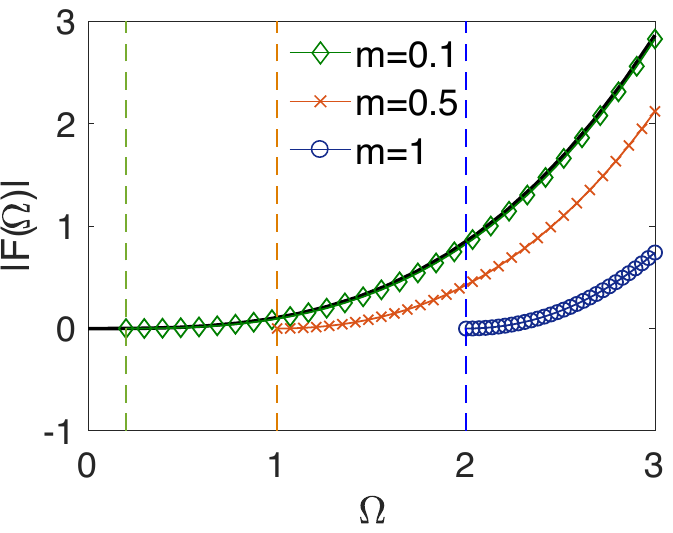
Figure 2. Frequency spectra of | F [ Ω ] | , in which we set the Fourier components of motion q [ Ω ] = 1. The black solid line denotes the results for the massless field. Note the units introduced in Section 1; the dimension of all the quantities can be expressed in terms of mass throughout this